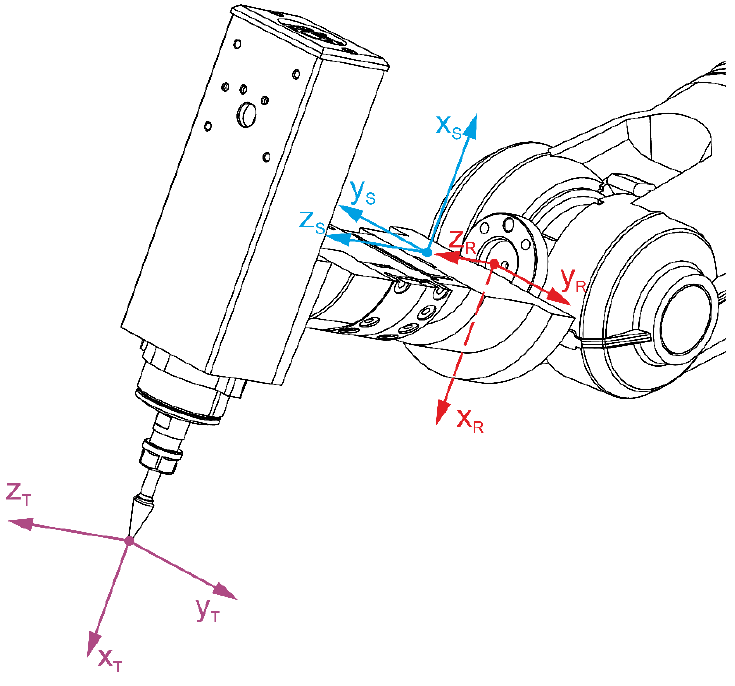
Figure 3. Diagram of the setting of a reference system in relation to the manipulator flange, x R y R z R —reference system related to the manipulator flange, x S y S z S —reference system related to the force sensor, x T y T z T —reference system for